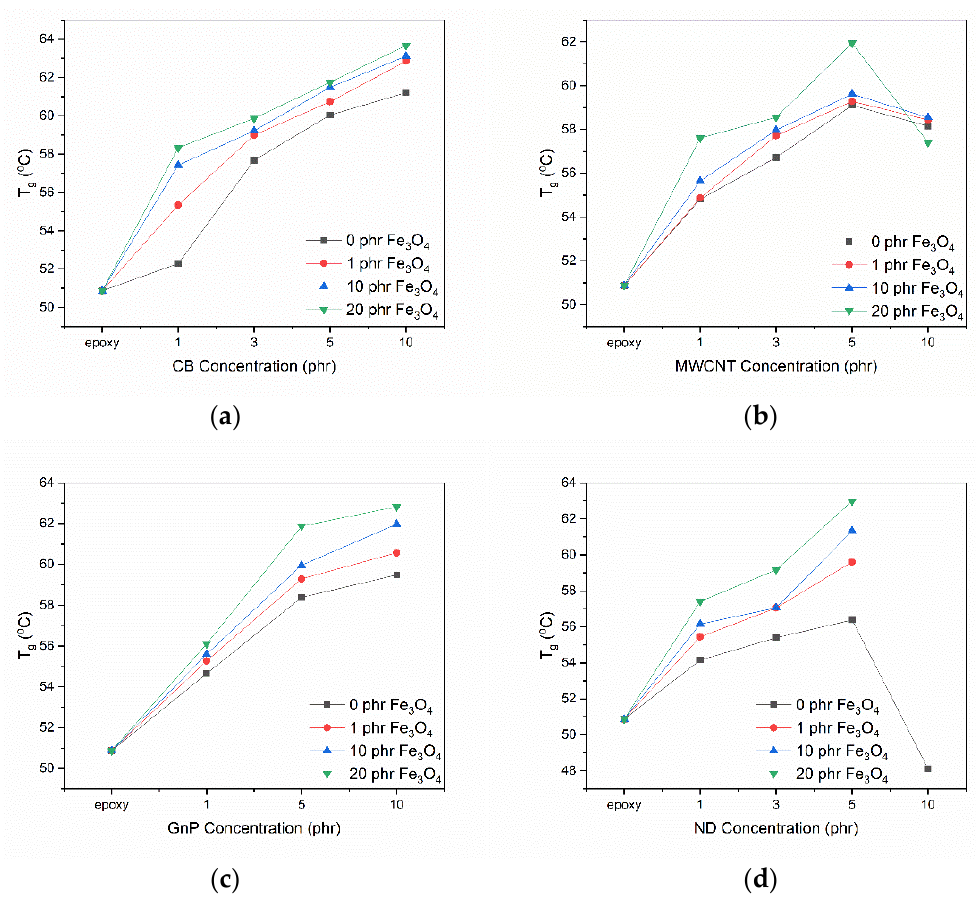
Figure 3. Glass transition temperature as a function of ( a ) CB; ( b ) MWCNT; ( c ) GnP; ( d ) ND concen- tration for all examined systems.